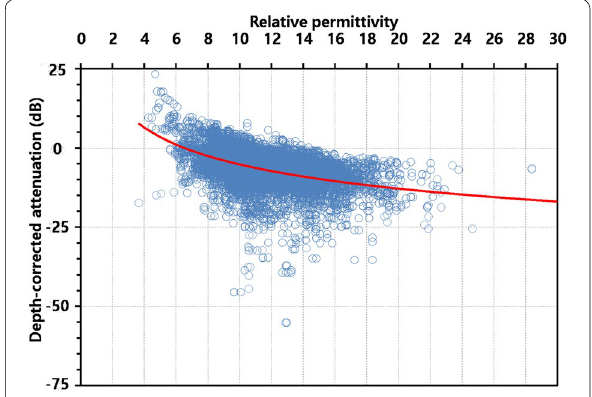
Fig. 15 Relationship between the depth‑corrected attenuation of concrete cover and the relative permittivity of concrete on the top surface of the bridge